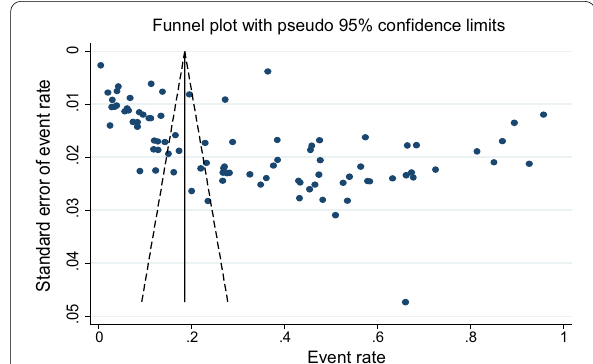
Fig. 4 Publication bias assessment plot: Egger’s regression test ( p < 0.0001) and Begg’s rank correlation ( p < 0.001)